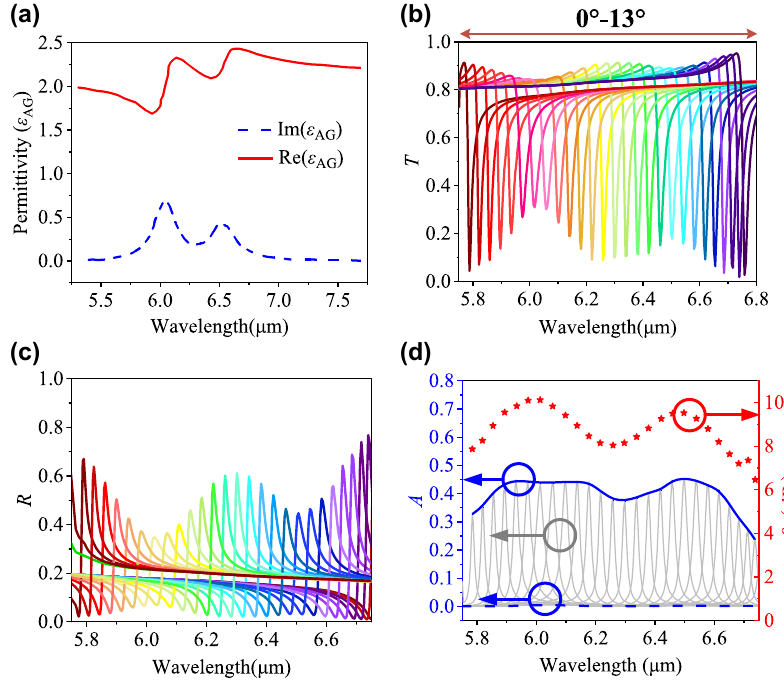
Figure 4: Permittivity of protein A/G and its detection results. (a) Real part and imaginary part of permittivity of protein